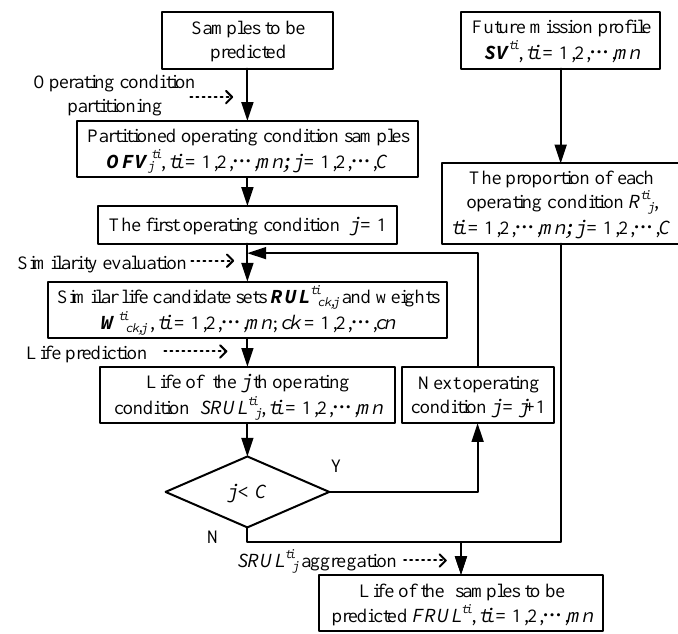
Figure 4. The process of the life prediction.